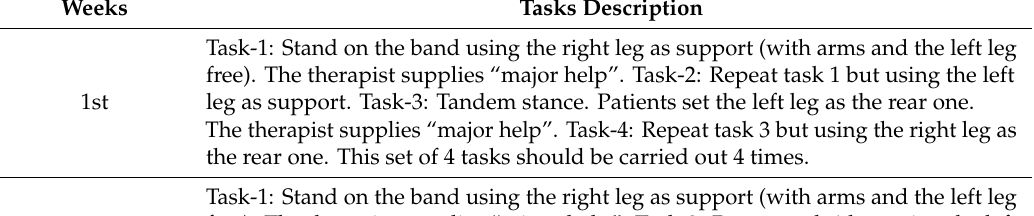
Table 1. Description of the tasks performed during the slackline program. Tasks